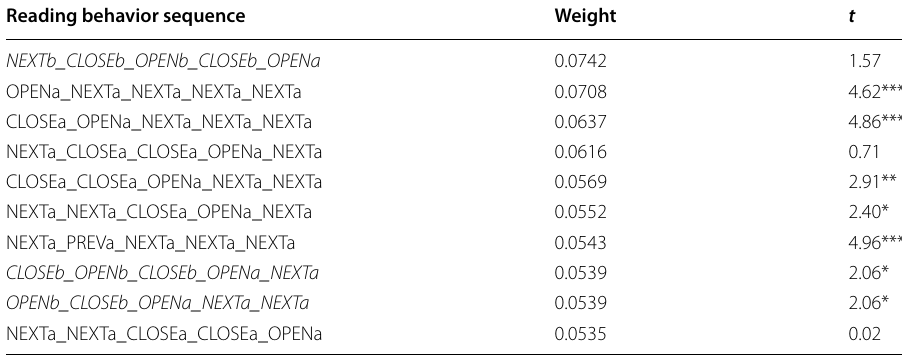
Table 10 Characteristic reading behaviors of high engagement